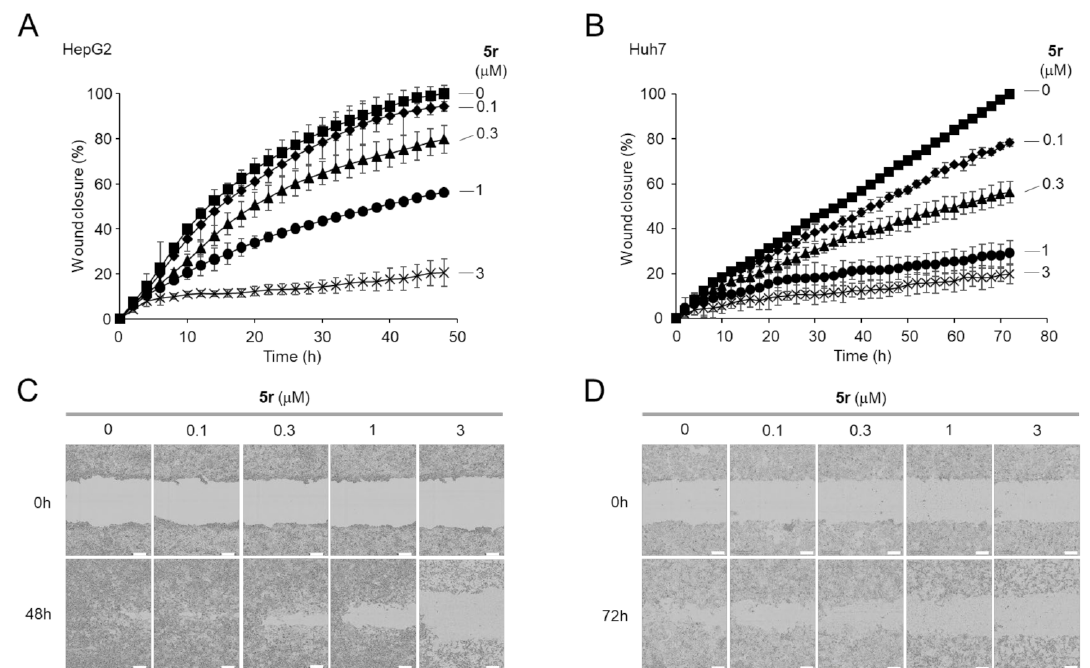
Figure 3. Inhibitory effect of 5r on cell migration in HepG2 and Huh7 cells. ( A , B ) In vitro wound- healing assay was performed in HepG2 and Huh7 cells (mean ± S.D., n = 3). HepG2 and Huh7 cells were treated with the indicated concentrations of 5r , and time-lapse images were acquired every 2 h after wound infliction. ( C , D ) Representative images were taken at 0, 48, or 72 h following administration of 5r at the indicated